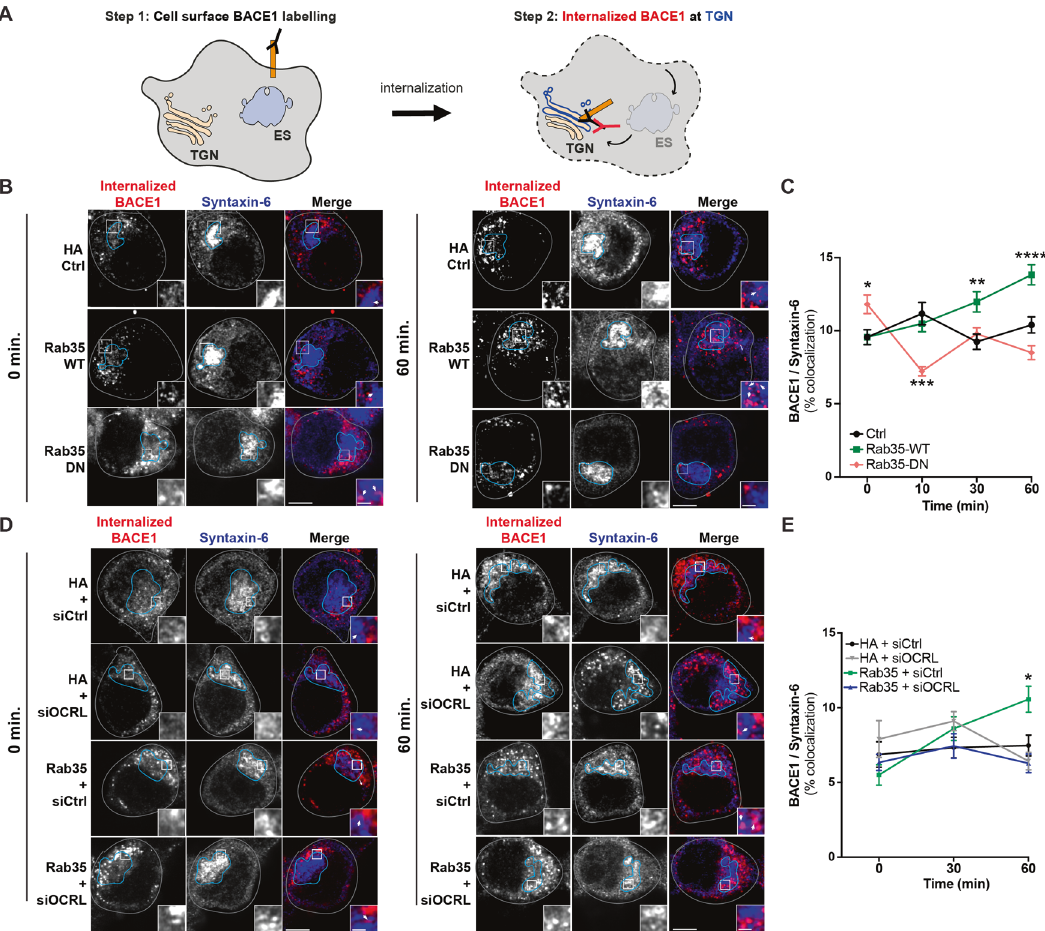
Fig. 4 Rab35 stimulates retrograde traf fi cking of BACE1 via OCRL. A Schematic representation of BACE1 internalization assay, in which cell- surface BACE1 was labeled with FLAG antibody, cells were incubated for 0, 10, 30, or 60 min to allow for BACE1 internalization, and fi nally, cells were immunostained with syntaxin-6 antibodies to label the TGN. B , C Representative high-resolution images (Zeiss Airyscan) and quanti fi cation of BACE1 internalization in N2a cells expressing FLAG-BACE1 and either HA Control, HA-Rab35 wild-type (WT), or HA-Rab35 dominant-negative (DN). Internalized BACE1 (red) and syntaxin-6 (blue) are shown at 0 and 60 min time points post-labeling, with cells outlined in gray, the TGN outlined in blue, and white arrowheads pointing to areas of colocalization in insets (* P DN-0min = 0.0392, ** P DN-10min = 0.0011, ** P WT-30min = 0.0025, **** P WT-60min < 0.0001; 2-way ANOVA and Sidak post hoc analysis, n = 45 – 155 cells per condition/timepoint, 2 – 5 experiments. Time × Rab35 interaction F 6,1253 = 8.002, P < 0.0001, overall Rab35 effect F 2,1253 = 10.43, P < 0.0001). D , E Representative high- resolution images (Zeiss Airyscan) and quanti fi cation of BACE1 internalization in N2a cells expressing FLAG-BACE1 and HA or HA-Rab35 together with control siRNA (siCtrl) or siRNA to knockdown OCRL (siOCRL). Internalized BACE1 (red) and syntaxin-6 (blue) are shown at 0